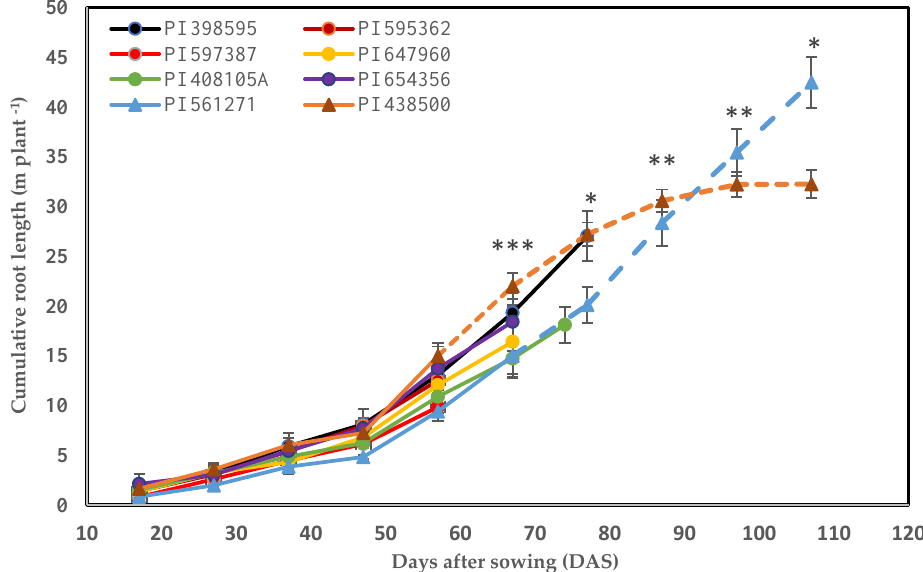
Figure 3. Non-destructively measured cumulative visible root length by root mapping through glass panels every 10 days from 17 days after sowing (DAS) until the first flower appeared in both plants in each rhizobox. Dashed lines are two genotypes (PI 438500 & PI 561271) grown until the roots of PI 561271 reached the bottom of the rhizobox. Values are the mean ± standard error of three repli- cates (two plants per rhizobox). *, **, and *** indicate significant difference among genotypes at p < 0.05, p < 0.01, and p < 0.001, respectively.